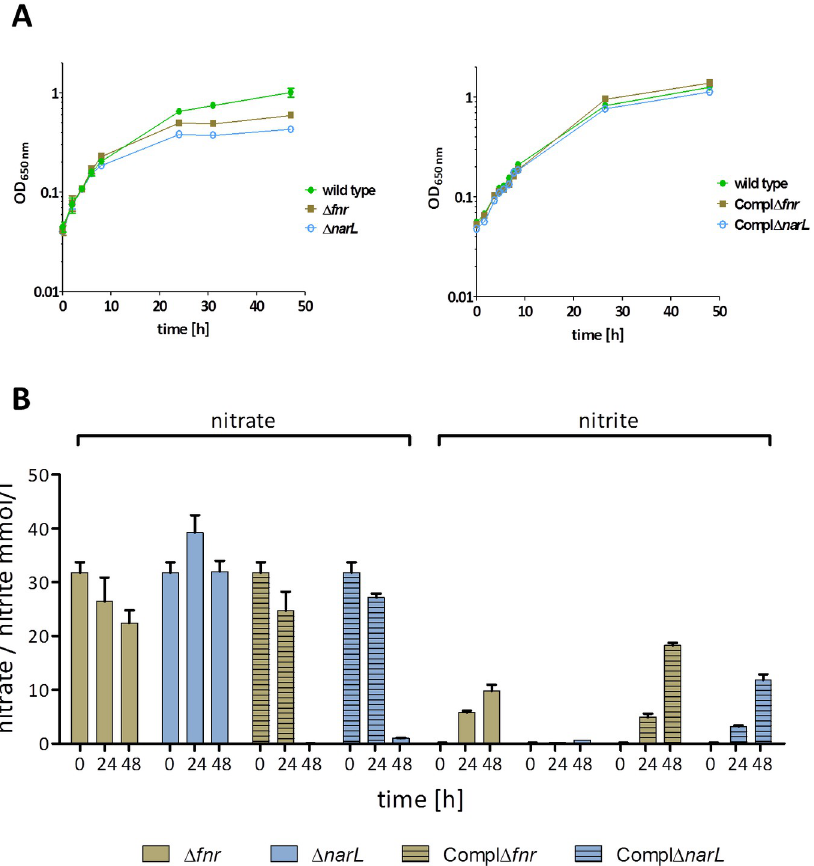
Fig 5. Growth and determination of extracellular nitrate and nitrite of B . pseudomallei wild type strain, Δ fnr and Δ narL mutants and their respective complemented mutant strains. A: For growth curves, cells were anaerobically cultivated in LB medium supplemented with 50 mM nitrate. B: For the determination of nitrate and nitrite, the supernatants were harvested and concentrations of nitrate and nitrite were measured as described in Material and Methods. Shown are mean values of three independent experiments. Error bars indicate standard error of the mean (SEM).